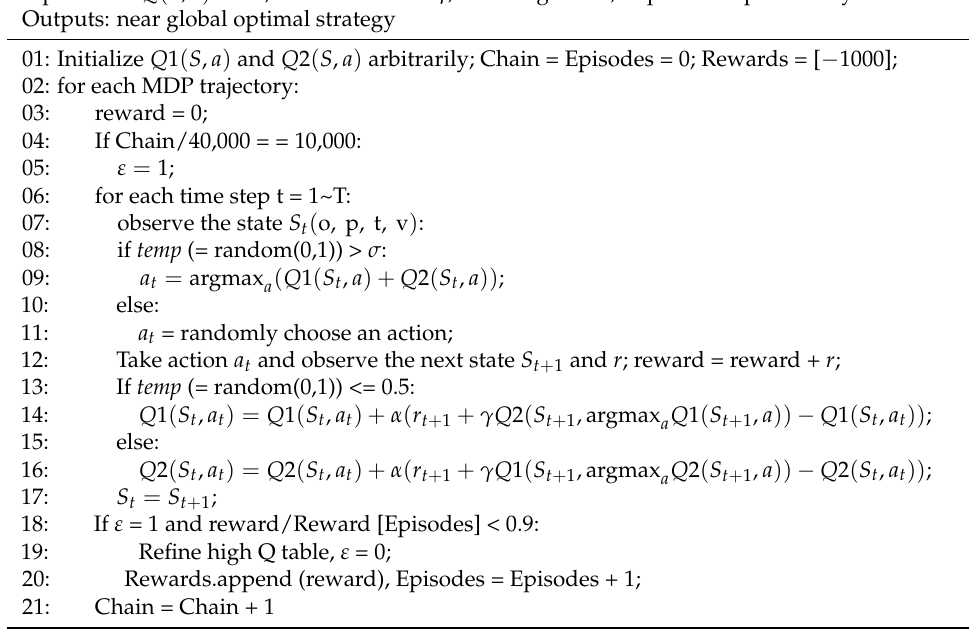
Table 3. Pseudo code of the improved double Q